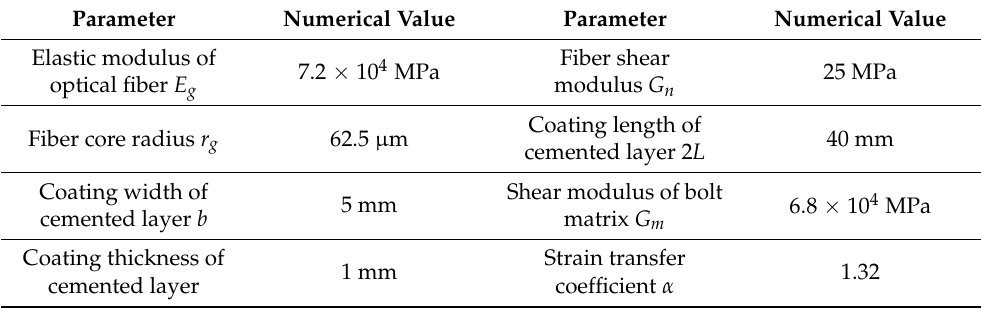
Table 1. Strain transfer constants of optical fiber layer, cemented layer, and bolt matrix.